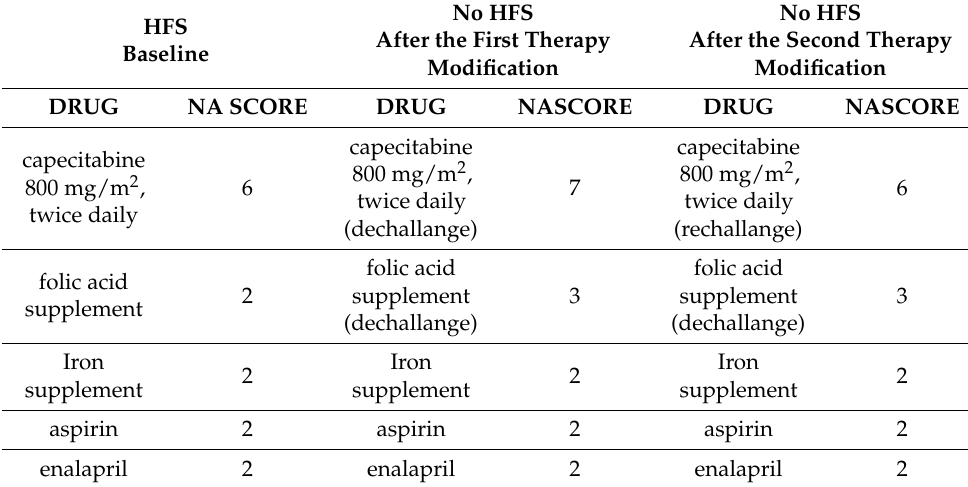
Table 4. Causality assessment performed using Naranjo Algorithm for patient